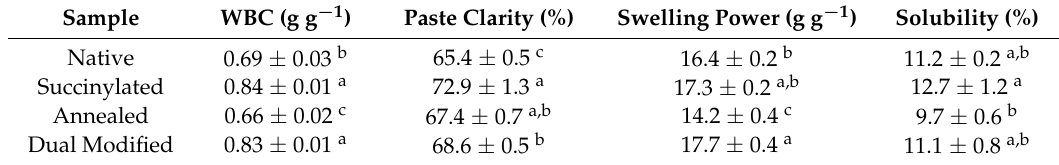
WBC: Water-binding capacity. Values represent the mean of triplicate measurements ± SD (Standard Deviation). Means within columns with different letters are significantly different ( p <